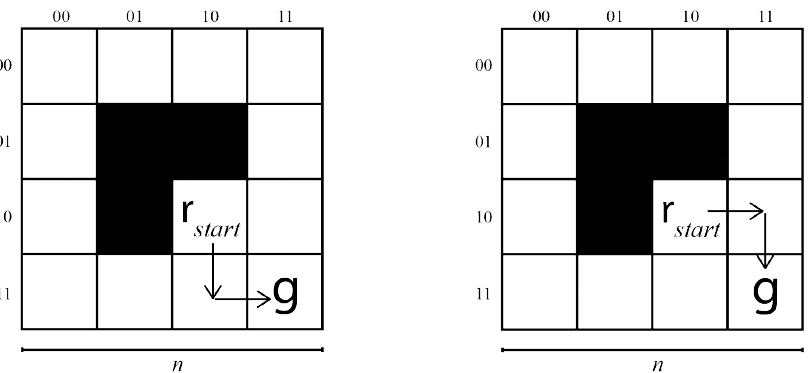
Figure 24. Evaluated paths from r start to g . Although those paths are similar to those evaluated